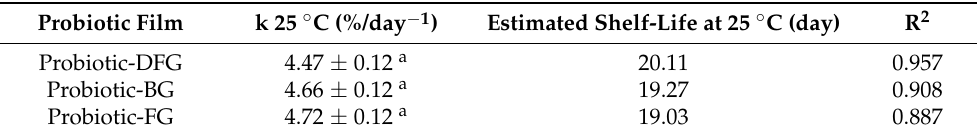
Table 1. Inactivation rates of L. casei immobilized in plasticized gelatin matrices (probiotic films) stored under room temperature condition.